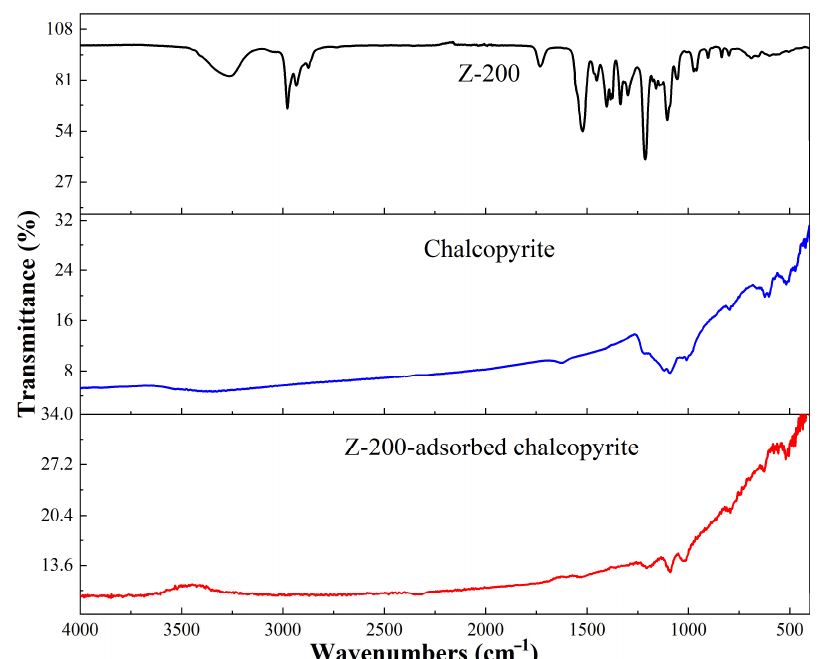
Figure 20. The FTIR spectra of Z-200, chalcopyrite, and Z-200-adsorbed